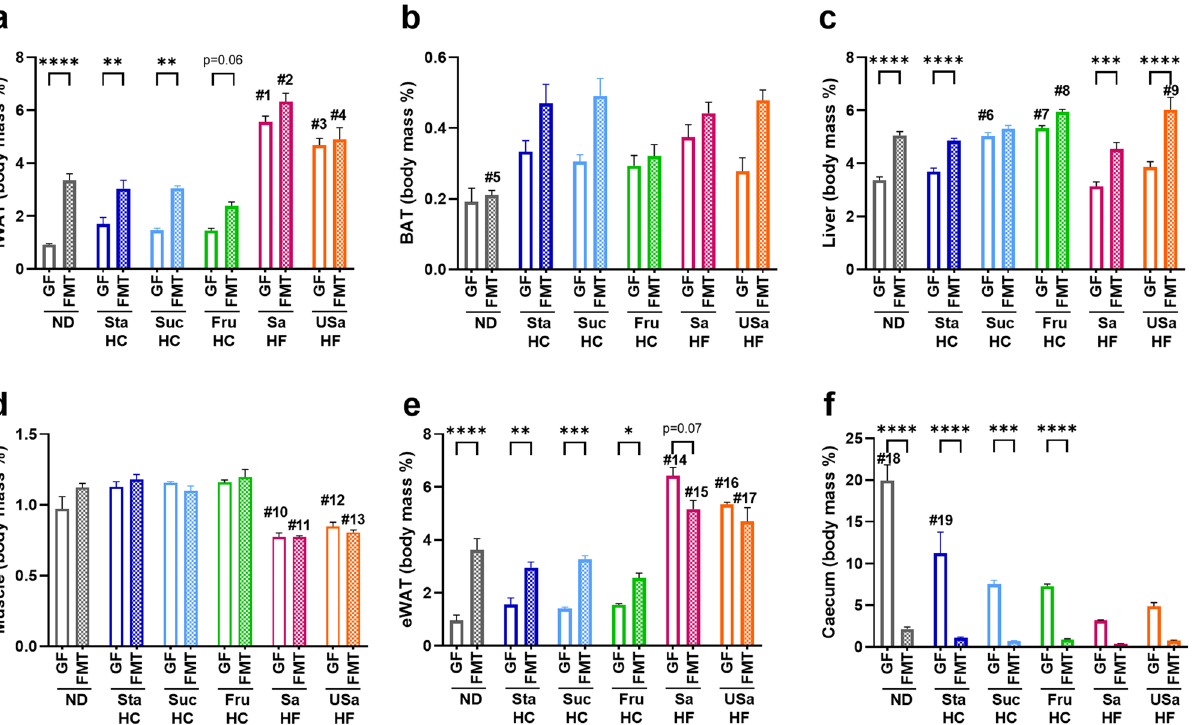
Figure 2. Difference in tissue weights between germ-free (GF) and fecal microbiota transplant (FMT) mice fed six different diets. The tissues analyzed included: ( a ) iWAT, ( b ) BAT, ( c ) liver ( d ) muscle, ( e ) eWAT, and ( f ) caecum with content. Values are expressed as the relative weight calculated based on organ weight/body weight (BW) (body mass %) and presented as the mean + SEM (n = 4 or 7). Multiple comparisons were analyzed using a two-way analysis of variance, followed by Tukey’s test. Asterisks (*) indicate significant differences between GF and FMT mice (* p < 0.05, ** p < 0.01, *** p < 0.001, and **** p < 0.0001). The # denotes the significance between the diet groups, and the statistical results pertaining to the number of # correspond to the number of # marked in Supplementary Table S3. iWAT inguinal white adipose tissue, BAT brown adipose tissue, muscle skeletal muscle, eWAT epididymal white adipose